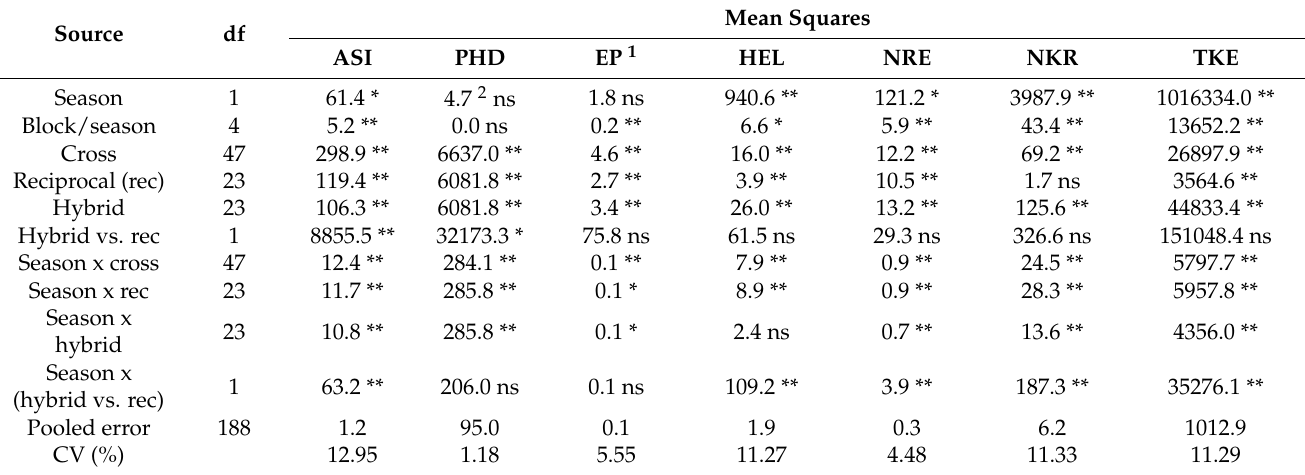
Table 2. Combined ANOVA for seed producer preferences including ASI (anthesis-silking interval), PHD (plant height difference), EP (ear position), HEL (husked ear length), NRE (row number per ear), NKR (kernel number per row), and TKE (total kernel number per ear) of 48 sweet-waxy corn crosses. Mean Squares HEL